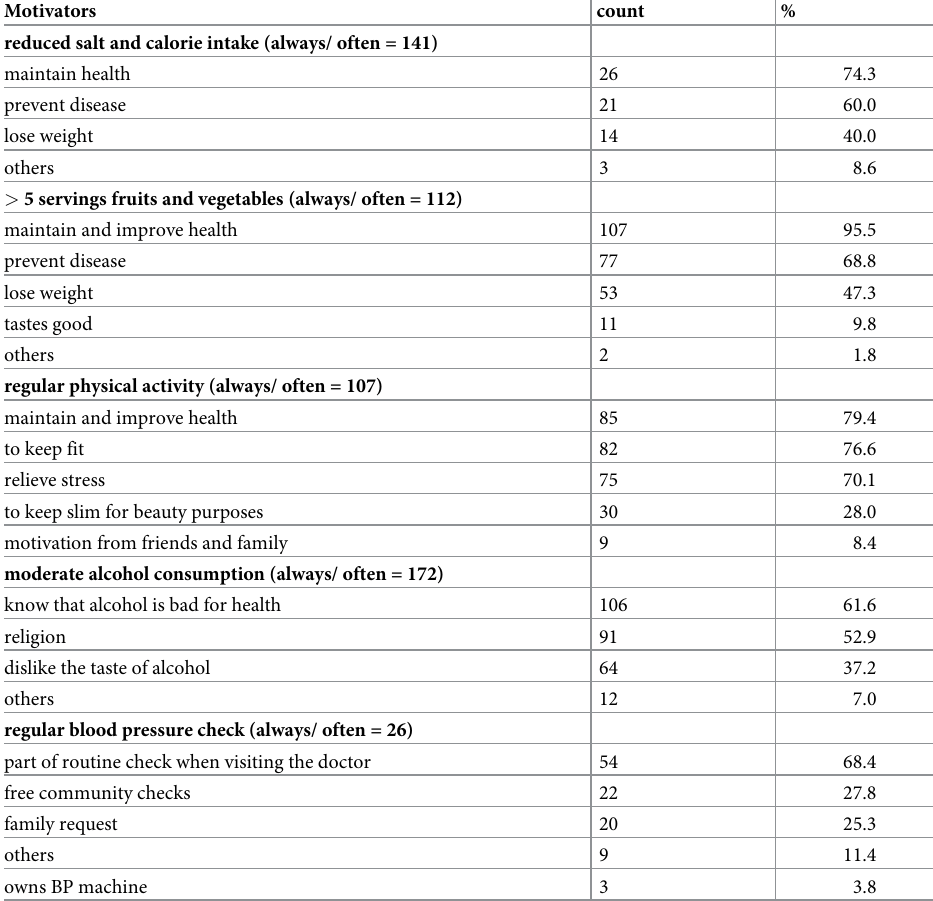
Table 4. Motivators to hypertension self-care behaviours. Motivators were obtained from participants whom ‘always’ or ‘often’ carry out these behaviours. Motivators count